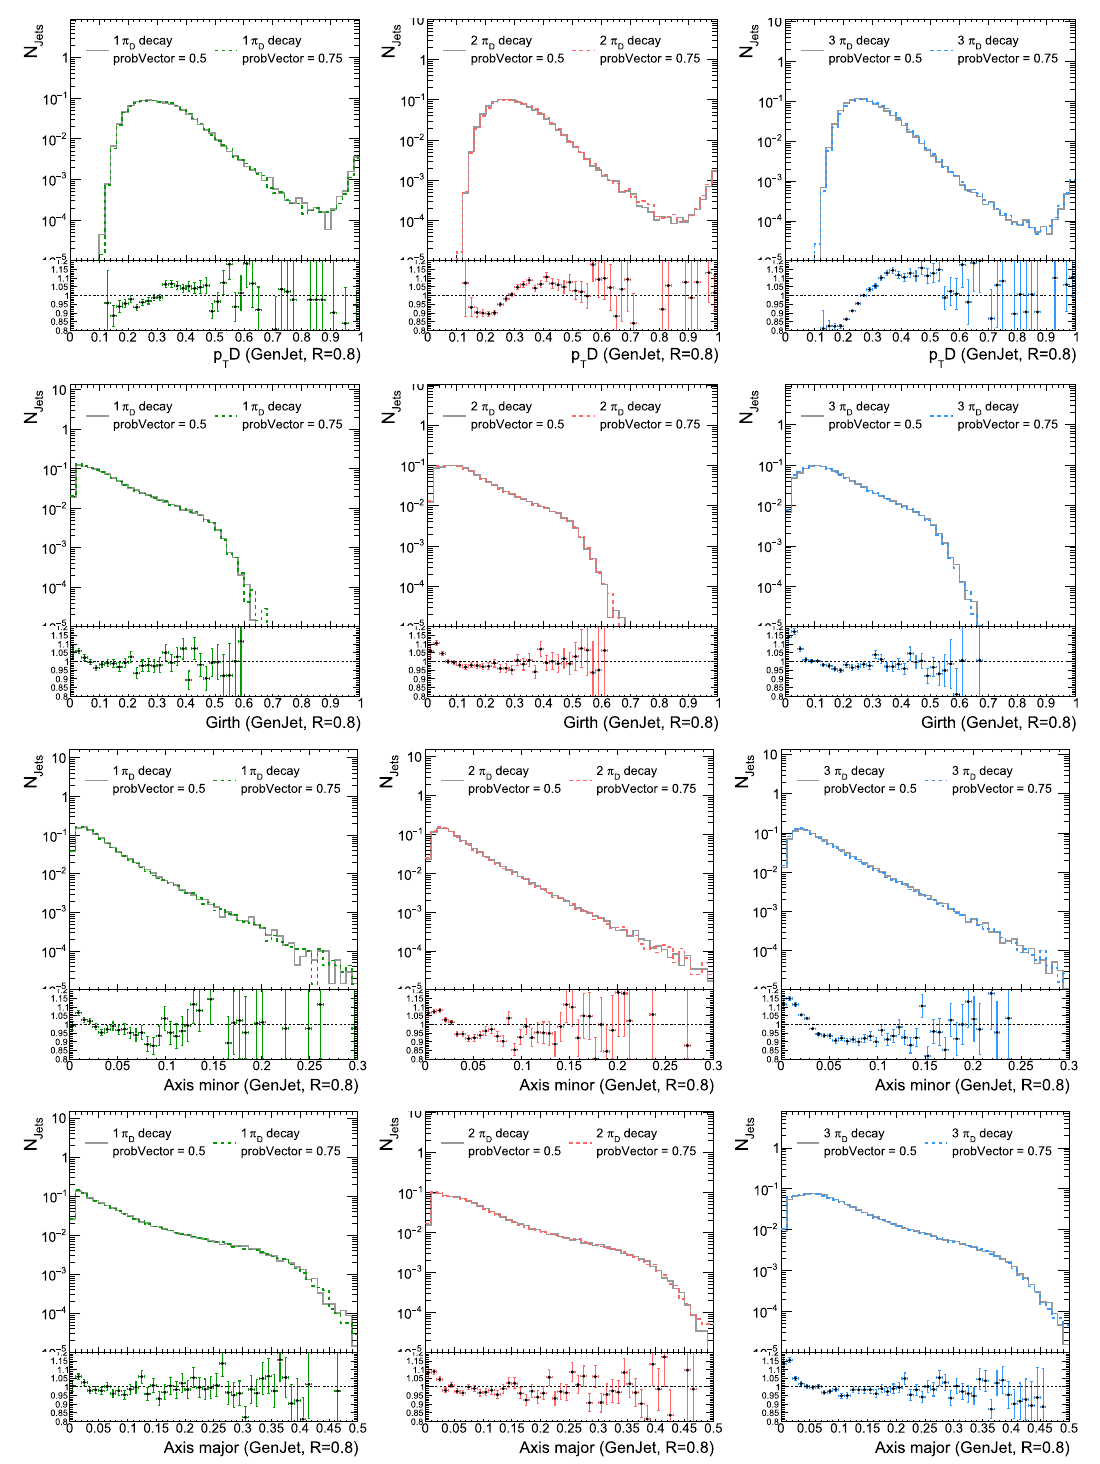
Fig. 41 Comparison of quark-gluon discriminant variables between probVector=0.5 (grey solid line) and probVector=0.75 (colored dashed line). The comparison is made for 1 (left), 2 (middle) and 3 (right) dark pions decay. The plotted ratio is the ratio of probVector=0.75 to